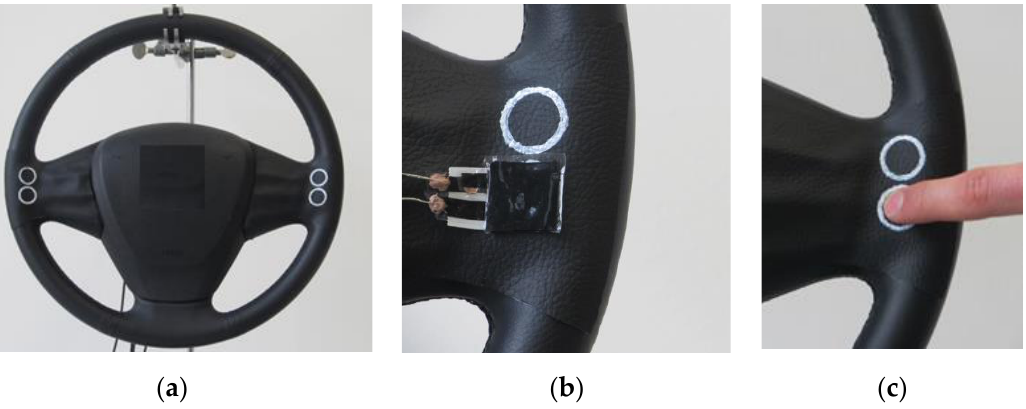
Figure 22. Control interface with four pressure sensors integrated into an automotive steering wheel in overview ( a ), below the opened leather cover ( b ) and operated with a finger ( c ) [103].